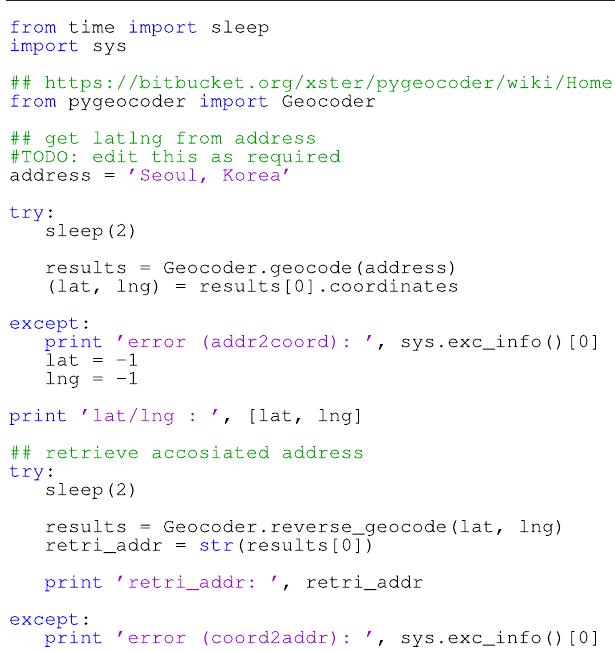
latitude and longitude from the Google Maps API. We set a delay of two seconds to avoid obtaining an error message of OVER QUERY LIMIT from the API [75], as we are dealing with a large set of